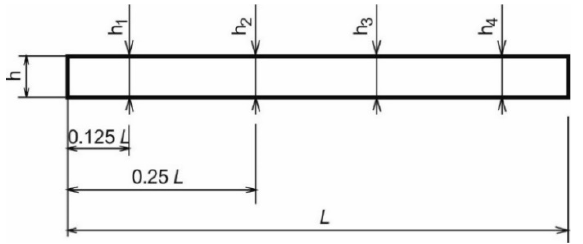
Figure 5. Scheme of measuring the thickness of samples.